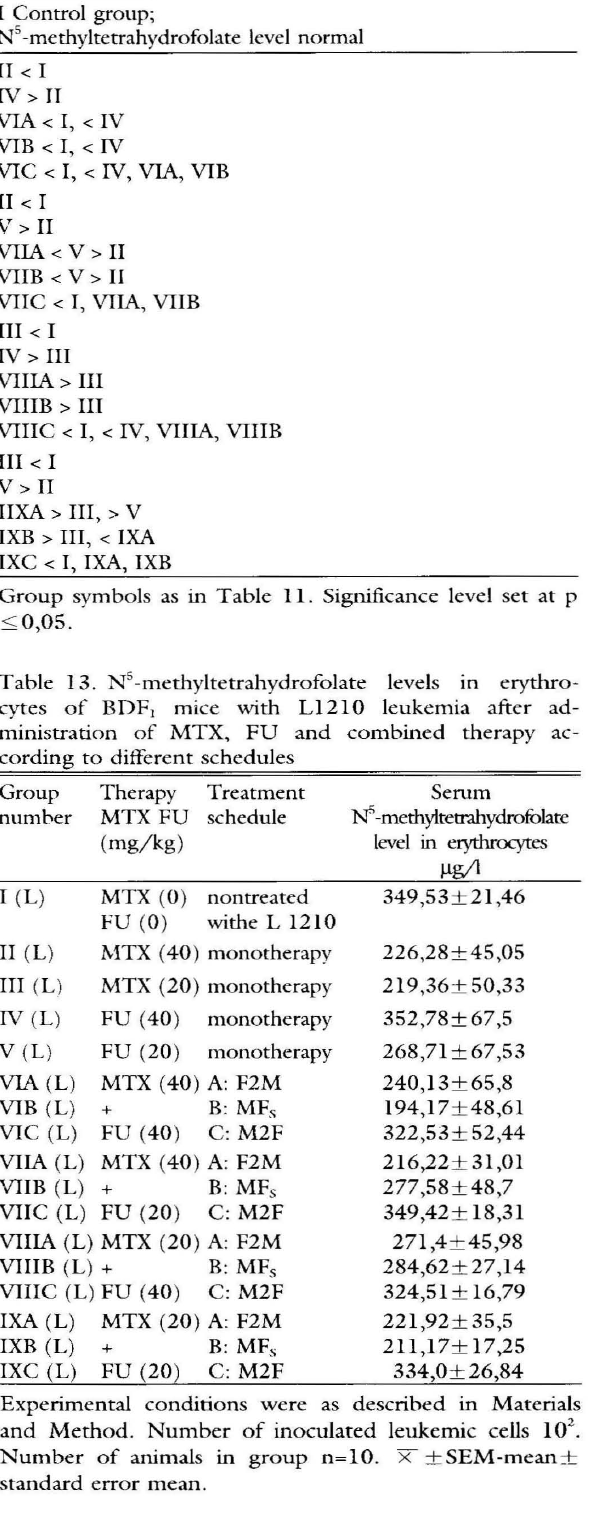
Table 12. Statistically significant differences between N 5 _ methyltetrahydrofolate levels in erythrocytes of healthy BDF, mice after administration of MTX, FU and com bined therapy according to different schedules